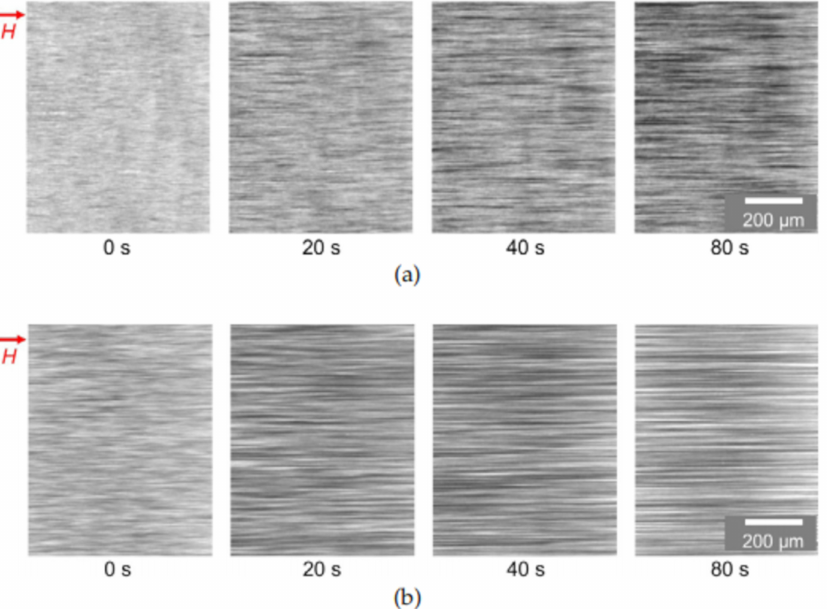
Figure 20. Structures formed by a multicore-based ferrofluid under the influence of a magnetic field of H = 20 kA / m ( a ) and H = 80 kA / m ( b ) for several time steps after the application of the respective magnetic field strength